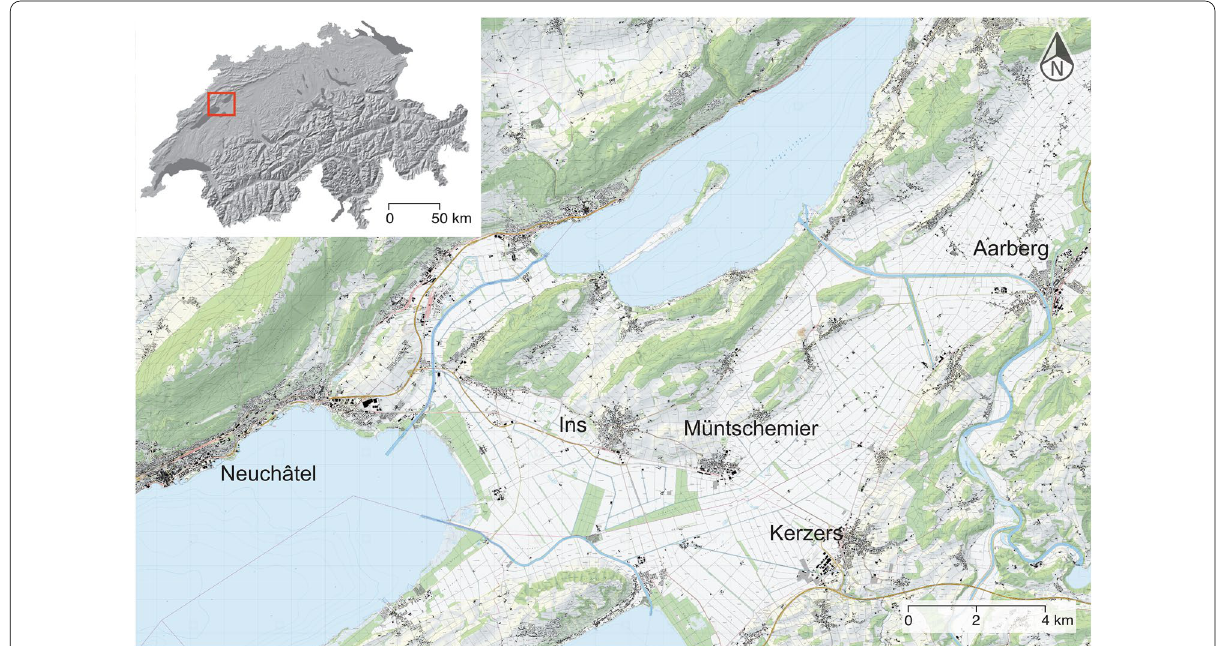
Fig. 1 Part of the Three Lakes Region of Western Switzerland. The area of interest lies between the Lake of Neuchâtel and Aarberg (Source: LK 25 swisstopo). The main plain between Ins, Kerzers and Aarberg is the ’Grosses Moos’